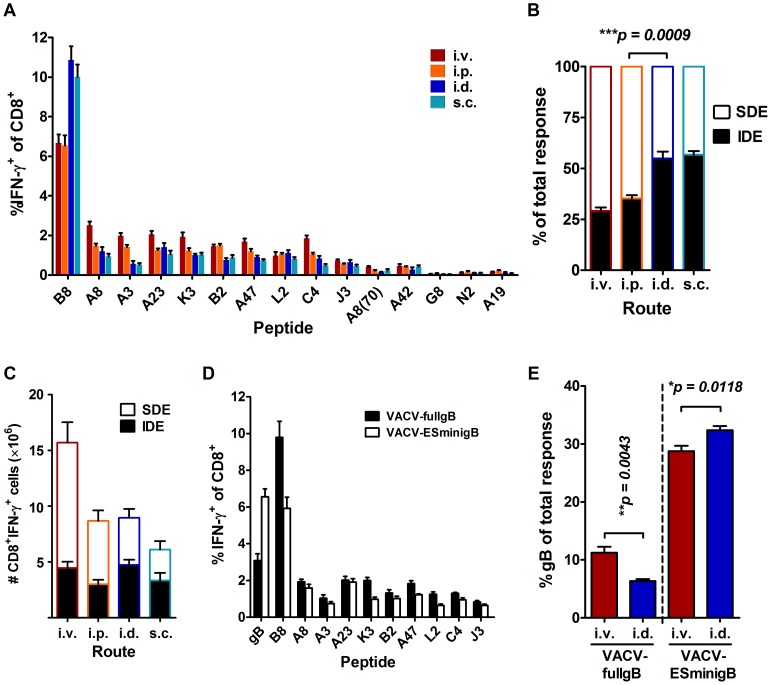
CD8+ T cell Immunodominance is altered by the route of infection for VACV.(A–C) CD8+ T cell responses to VACV epitopes were determined in C57BL/6 mice infected with 1×106 PFU of VACV WR by i.v., i.p., i.d., or s.c. injection seven days after infection. Data are from two or more experiments and total mice for each route were: i.v. 8, i.p. 16, i.d. 6 and s.c. 10. A) Means and SEM of percent of CD8+ T cells responding to each peptide. B) The fraction of all measured responses (sum of responses to all 15 VACV peptides) accounted for by B820-specific (IDE) and the sum of SDE-specific CD8+ T cells. C) Responses to VACV epitopes broken down into IDE and SDE as in panel B, but shown as total numbers of CD8+IFN-γ+ cells per spleen. (D–E) Responses to VACV and HSV gB498 epitopes seven days after infection of mice with 1×106 PFU of recombinant VACV-fullgB or VACV-ESminigB. Data are from two experiments with a total of 6 mice per virus. D) Means and SEM of percent of CD8+ T cells responding to each peptide after i.v. infection (10 of 14 VACV epitopes shown). E) Response to gB498 shown as a fraction of the total measured epitope-specific responses (VACV+gB498). Selected statistical significance denoted with p value over appropriate bars.